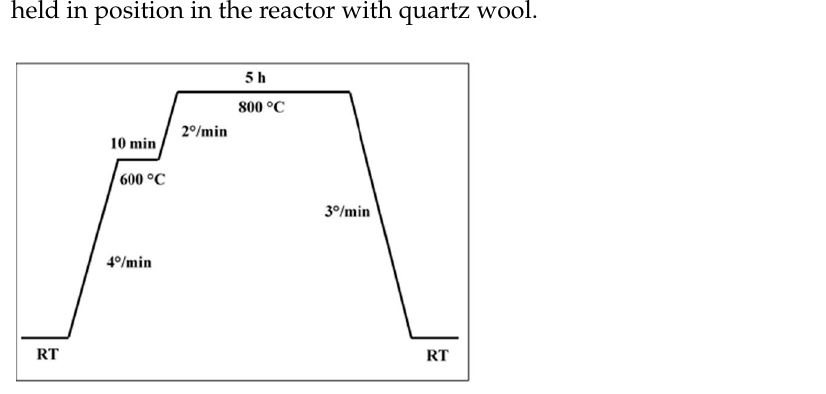
Figure 3. Calcination procedure for the thermal pre-treatment of the Mn/Na 2 WO 4 /SiO 2